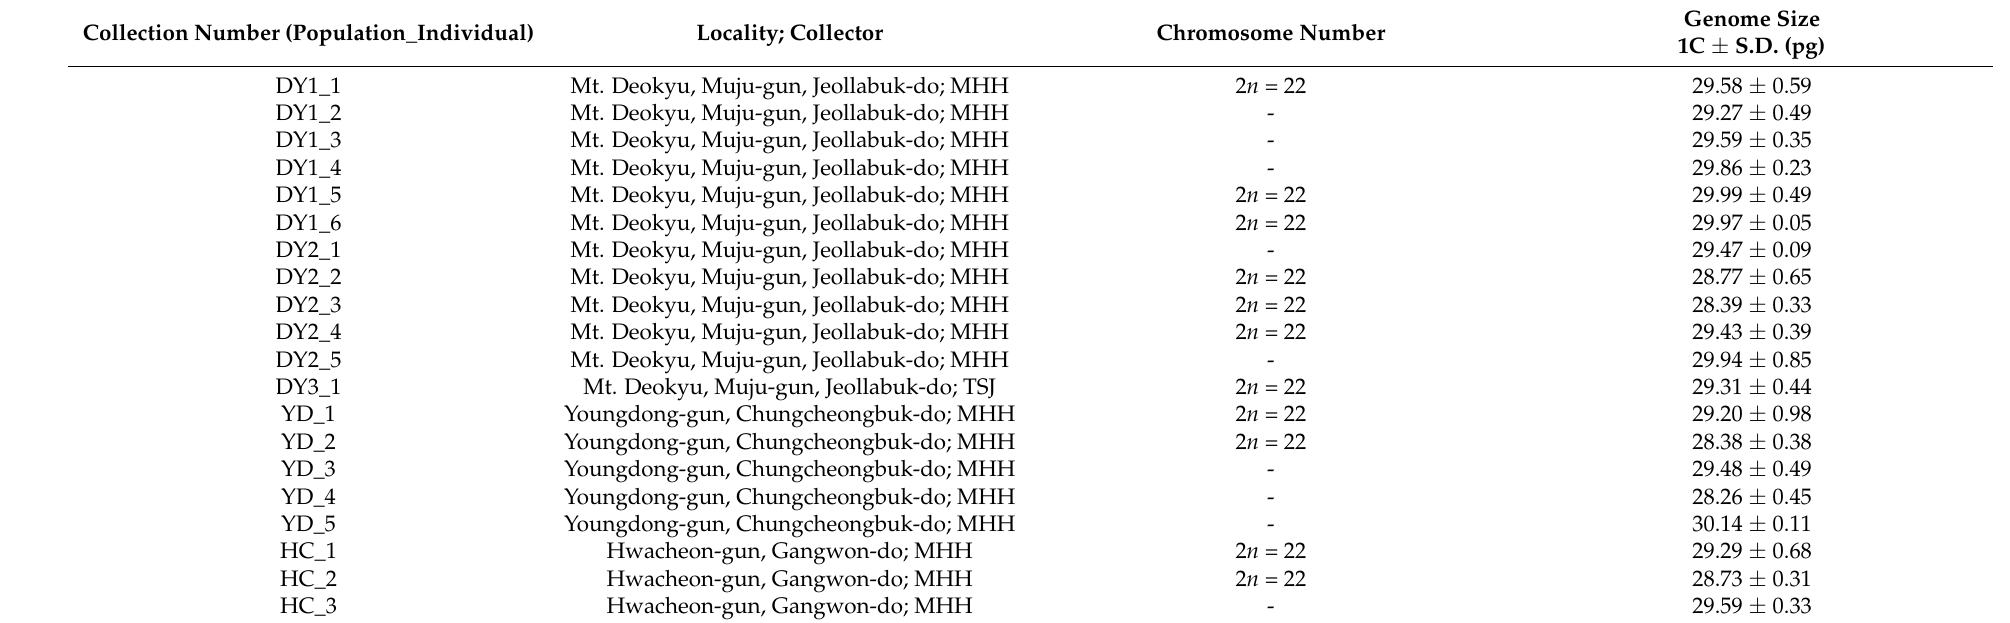
Table 1. Plant material used for cytogenetic analyses in Cypripedium japonicum